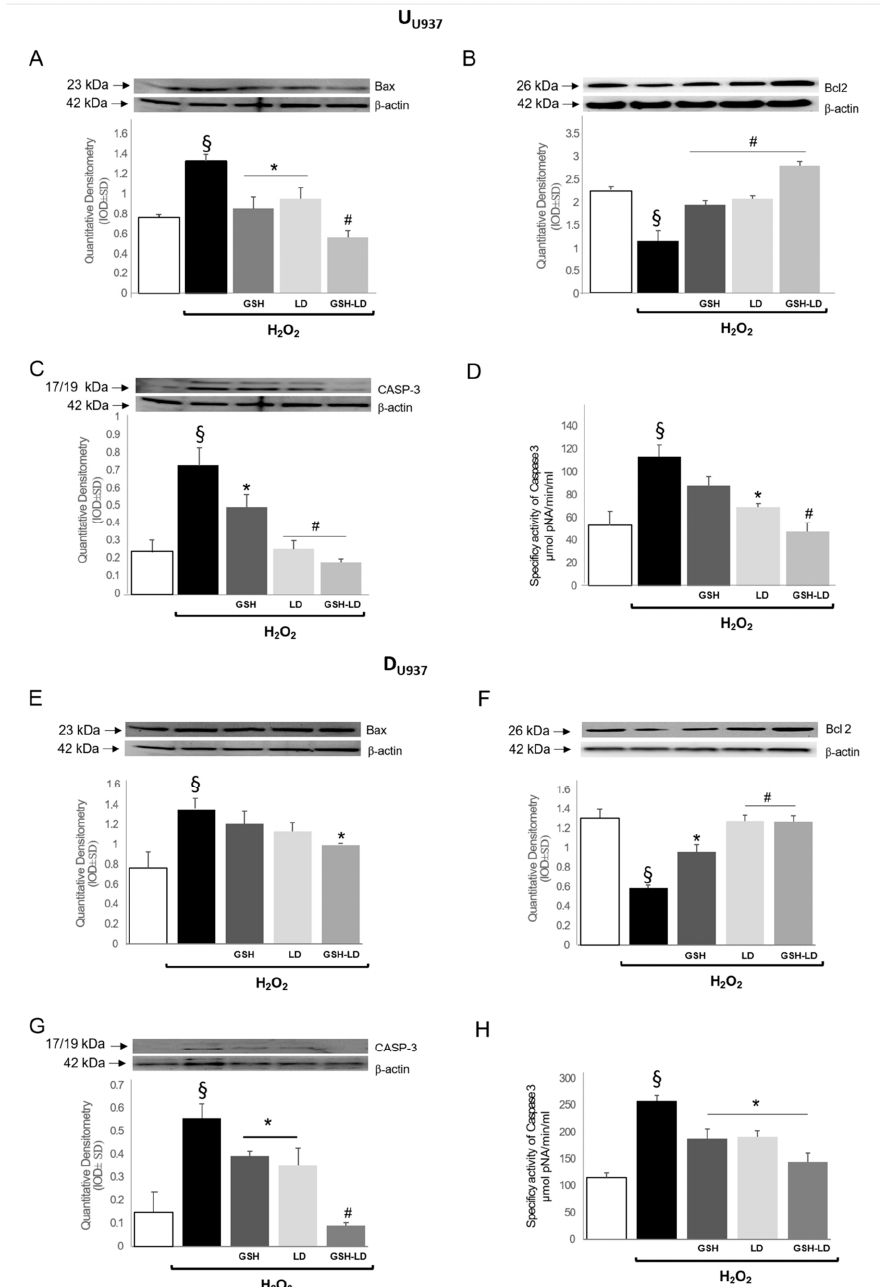
Figure 4. E ff ects of compounds on expression levels of apoptosis related proteins in monocytic cell line. E ff ect of GSH, LD and GSH-LD (10 µ M) on the expression levels of Bax ( A , E ) and Bcl-2 ( B , F ) and on caspase 3 expression and fluorescent activity ( C , D , G , H ), on H 2 O 2 -treated U U937 (upper) and D U937 (lower) cells. ß-actin was used as internal standard. Data is presented as the mean ± SD ( n = 6), § p < 0.05 vs. CTRL; # p < 0.01, * p < 0.05 vs. H 2 O 2 -treated